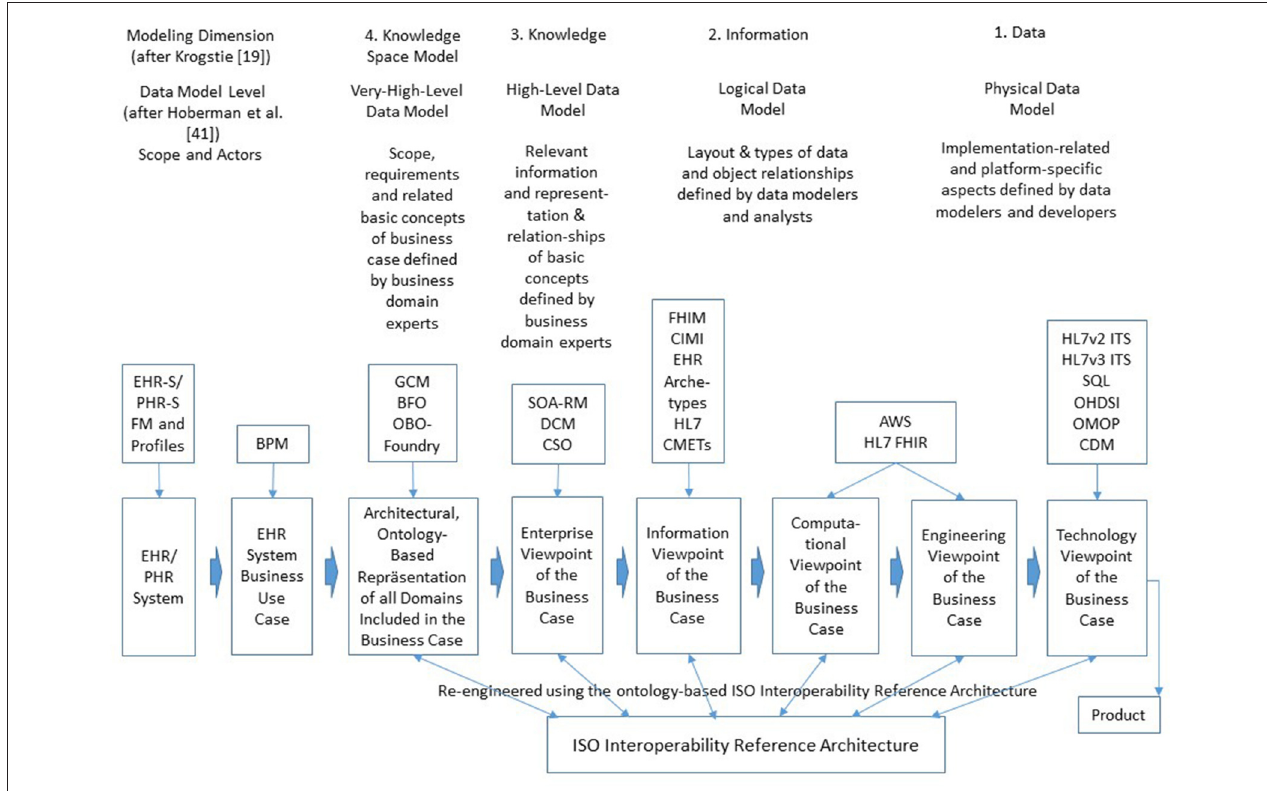
FIGURE 3 | Design and implementation framework for pHealth